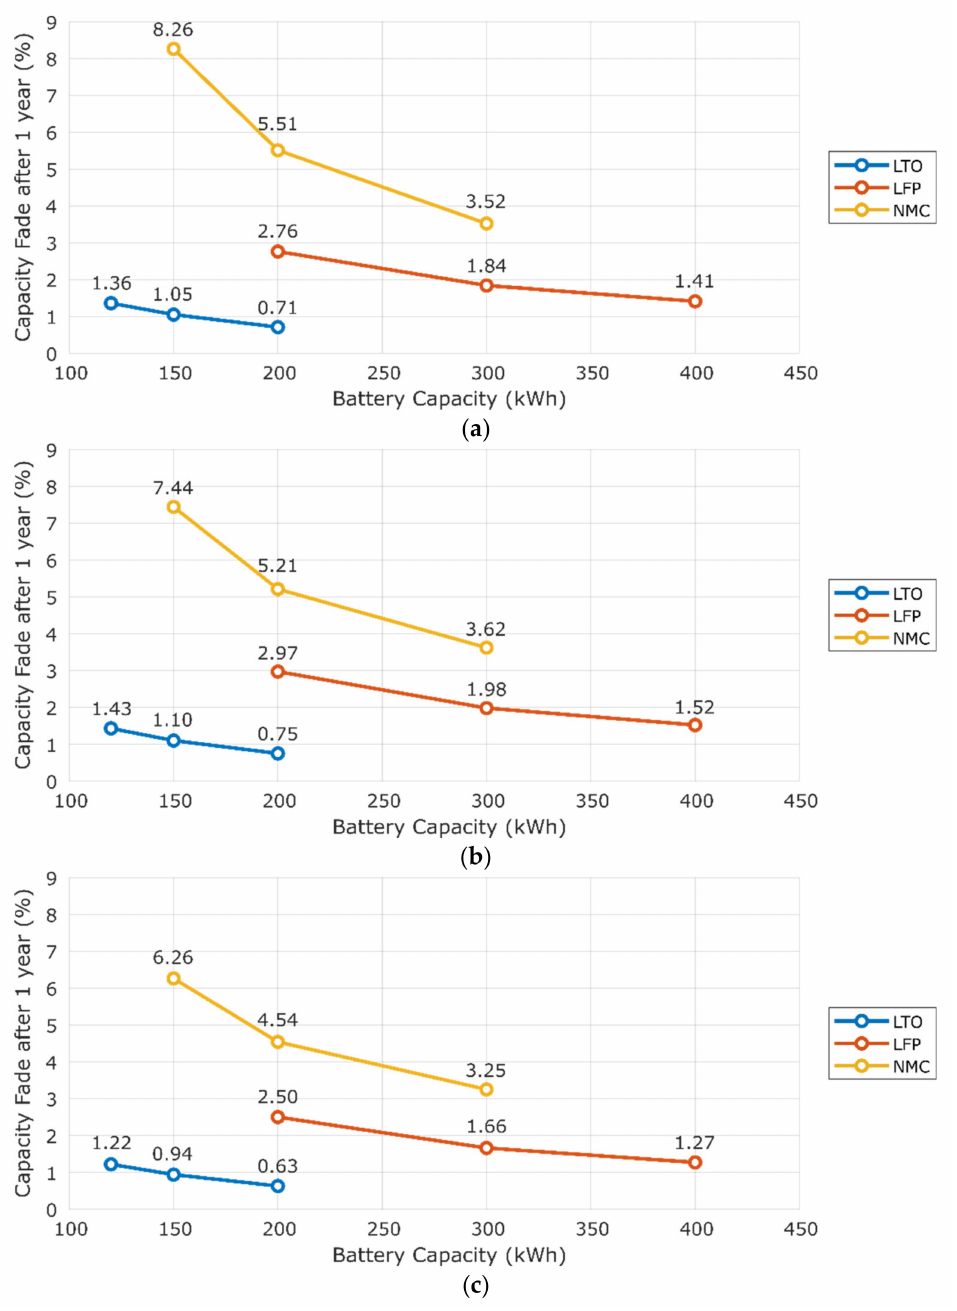
Figure 11. CF in the different case studies and scenarios (bus lines). ( a ) Barcelona bus line. ( b ) Osnabrück bus line. ( c ) Gothemburg bus